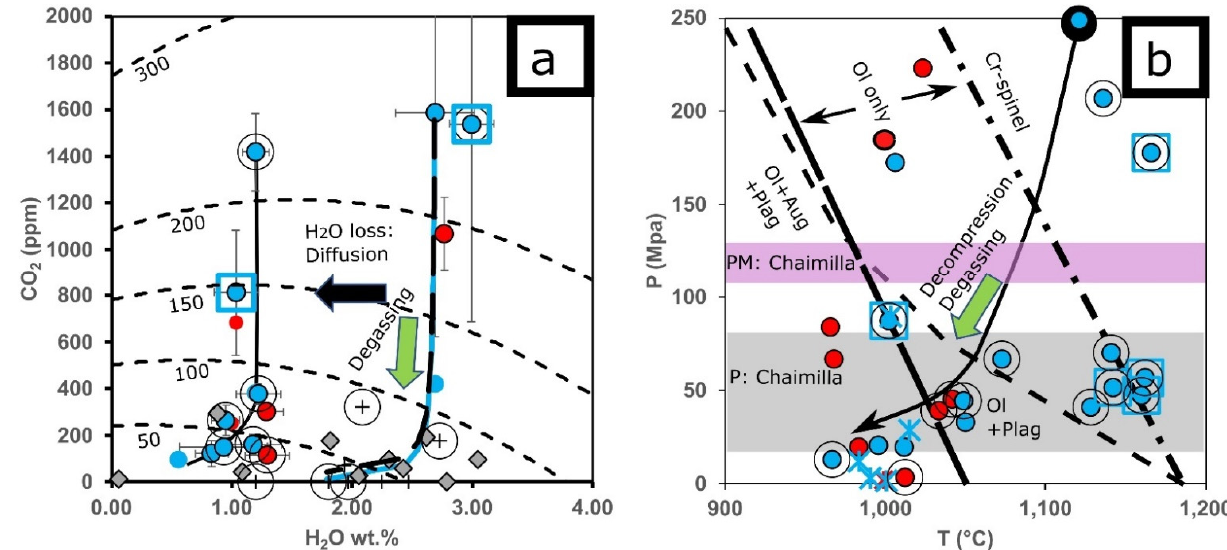
Figure 7. Pre-eruptive P-T conditions for inclusion entrapments. No effects are illustrated from post-entrapment modifica- tions except for the formation of bubbles and H 2 O diffusion. ( a ) CO 2 versos H 2 O diagram. The solubility model uses [71] with MI sample HLN2a922. Only fully enclosed inclusions are shown (open circle for the presence of observed vapor bubble). Vapor saturation isobars are calculated using [71], considering MI without vapor bubble had a fluid water mole fraction of 0.249 (matching the H 2 O-CO 2 content). The closed with open-system degassing path is illustrated with black dashed line and blue dashed line, respectively. Error bars from our study are determined in Section 3.4 (see also Figure S7). ( b ) Dry and hydrous phase relations for basaltic andesite are drawn approximatively and based on models of Moore and Carmichael (1998). Limit of mineral stability fields are illustrated with dotted lines (Ol is olivine; Aug is Augite; Plag is Plagioclase; Cr-Spinel is Chromium-Spinel). Only fully enclosed, glassy texture inclusions (open symbols) are plotted as they are considered to best represent the pre-eruptive melt with little to no effects from post-entrapment modifications. The green arrow represents the hypothetical magma crystallization path in tandem with decompression “degassing”. The temperatures are from method of Putirka (2008). Symbology is the same as previous figures. Purple rectangle indicates range of pressures from MIs of Chaimilla event (PM: Chaimilla; 120 Mpa), grey rectangle are the ranges of pressure from Chaimilla for minimum entrapment pressure in MIs of Chaimilla event (P: Chaimilla; [28]).